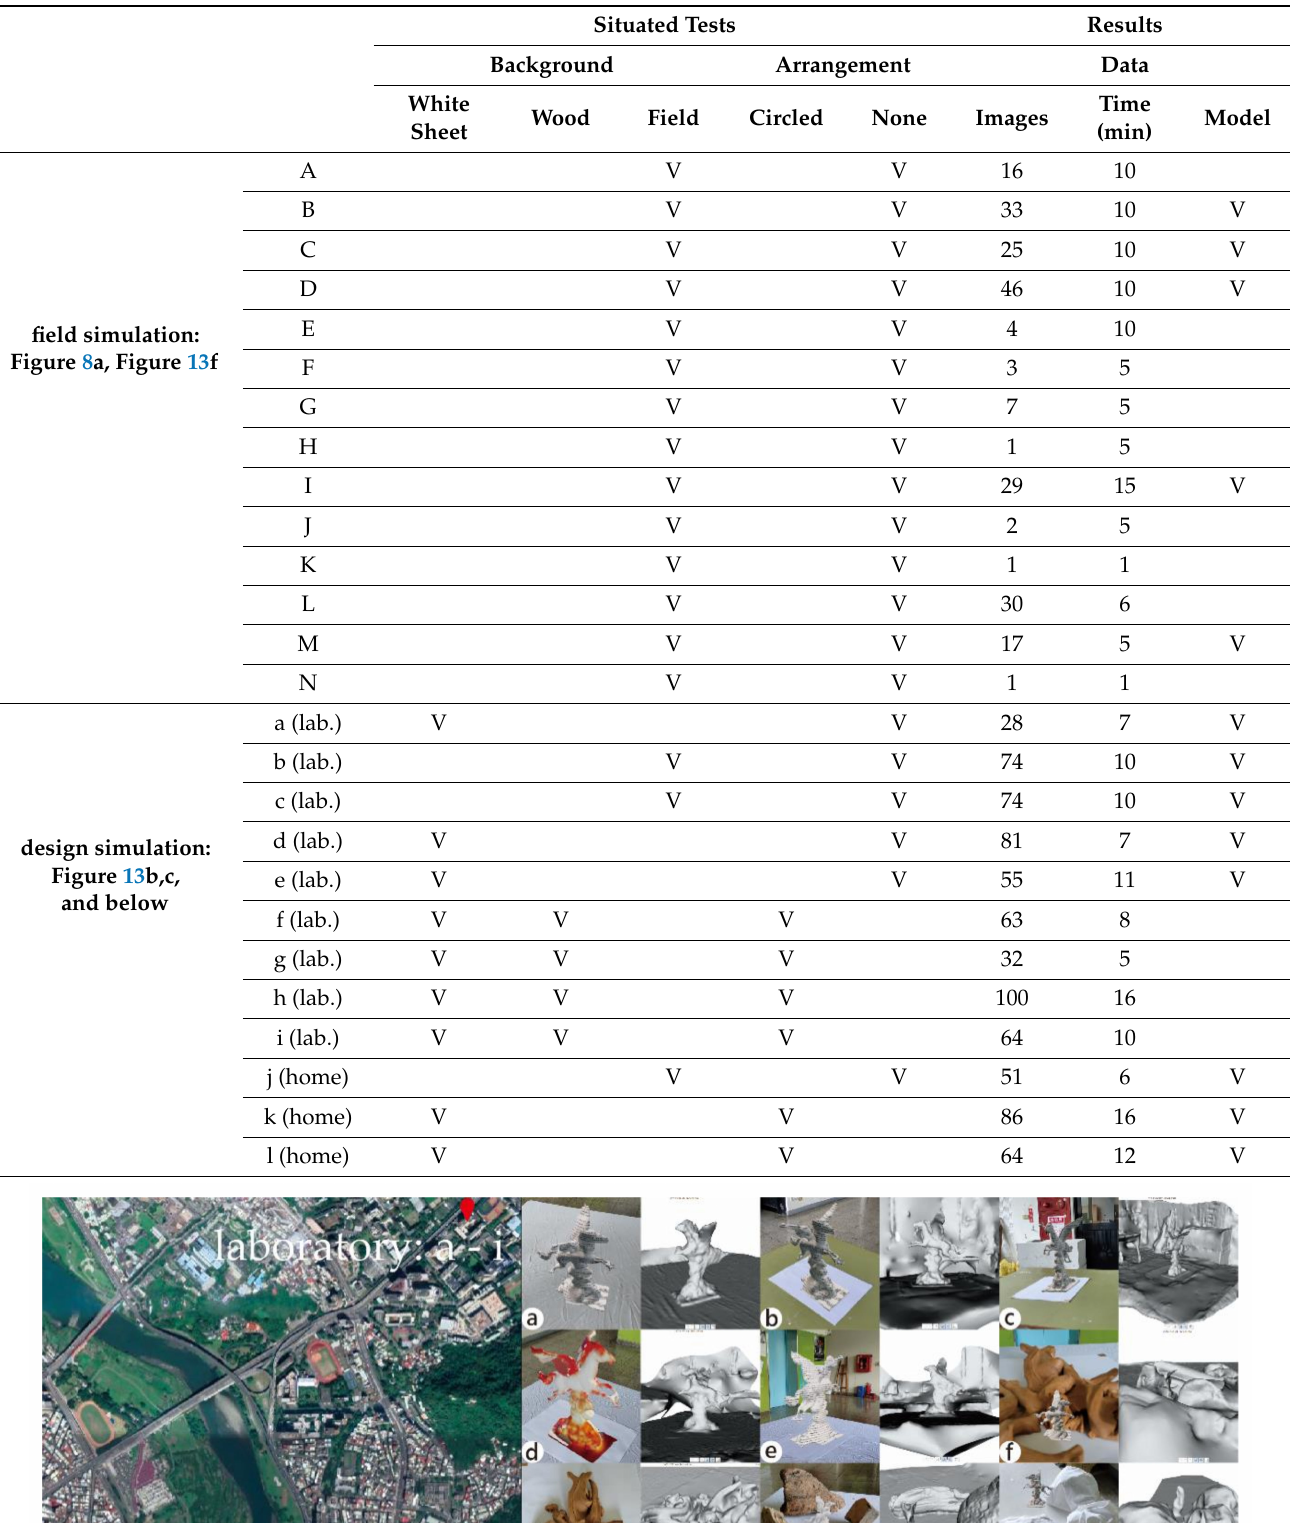
Table 1. Experiments in terms of field cases and design